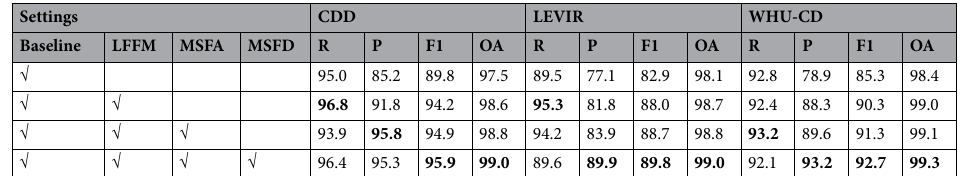
Table 5. Ablation experiment of innovative modules. All the scores are described in percentage (%) (the best performance is emphasized in